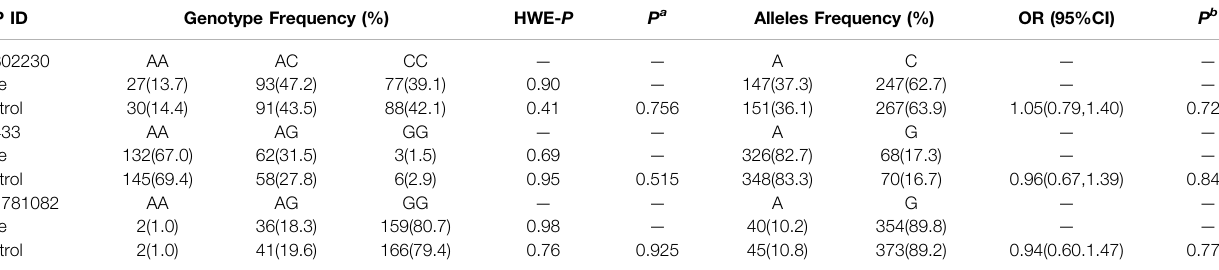
SNP,singlenucleotidepolymorphism;MAF,minorallelefrequency;HWE,Hardy – Weinbergequilibrium;ORs,oddsratios;CI,con fi denceinterval; p wereadjustedbygenderandage; P a presents the difference of genotypes between EH and healthy control patients; P b showsthe comparison of alleles between EH and healthycontrol subgroup; a p value of < 0.05 means statistical signi fi cance.